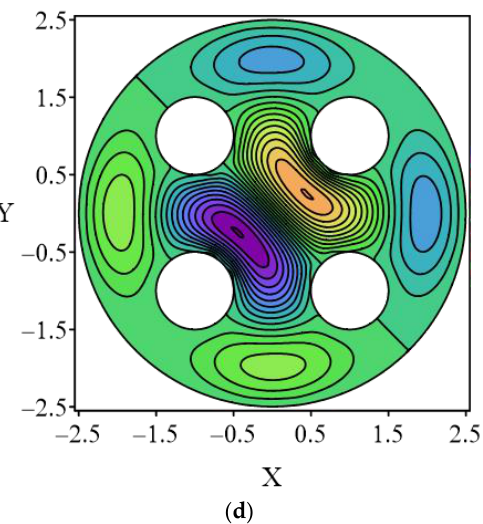
Figure 13. The first four eigenmodes for multi-connected domain waveguide (TM wave):